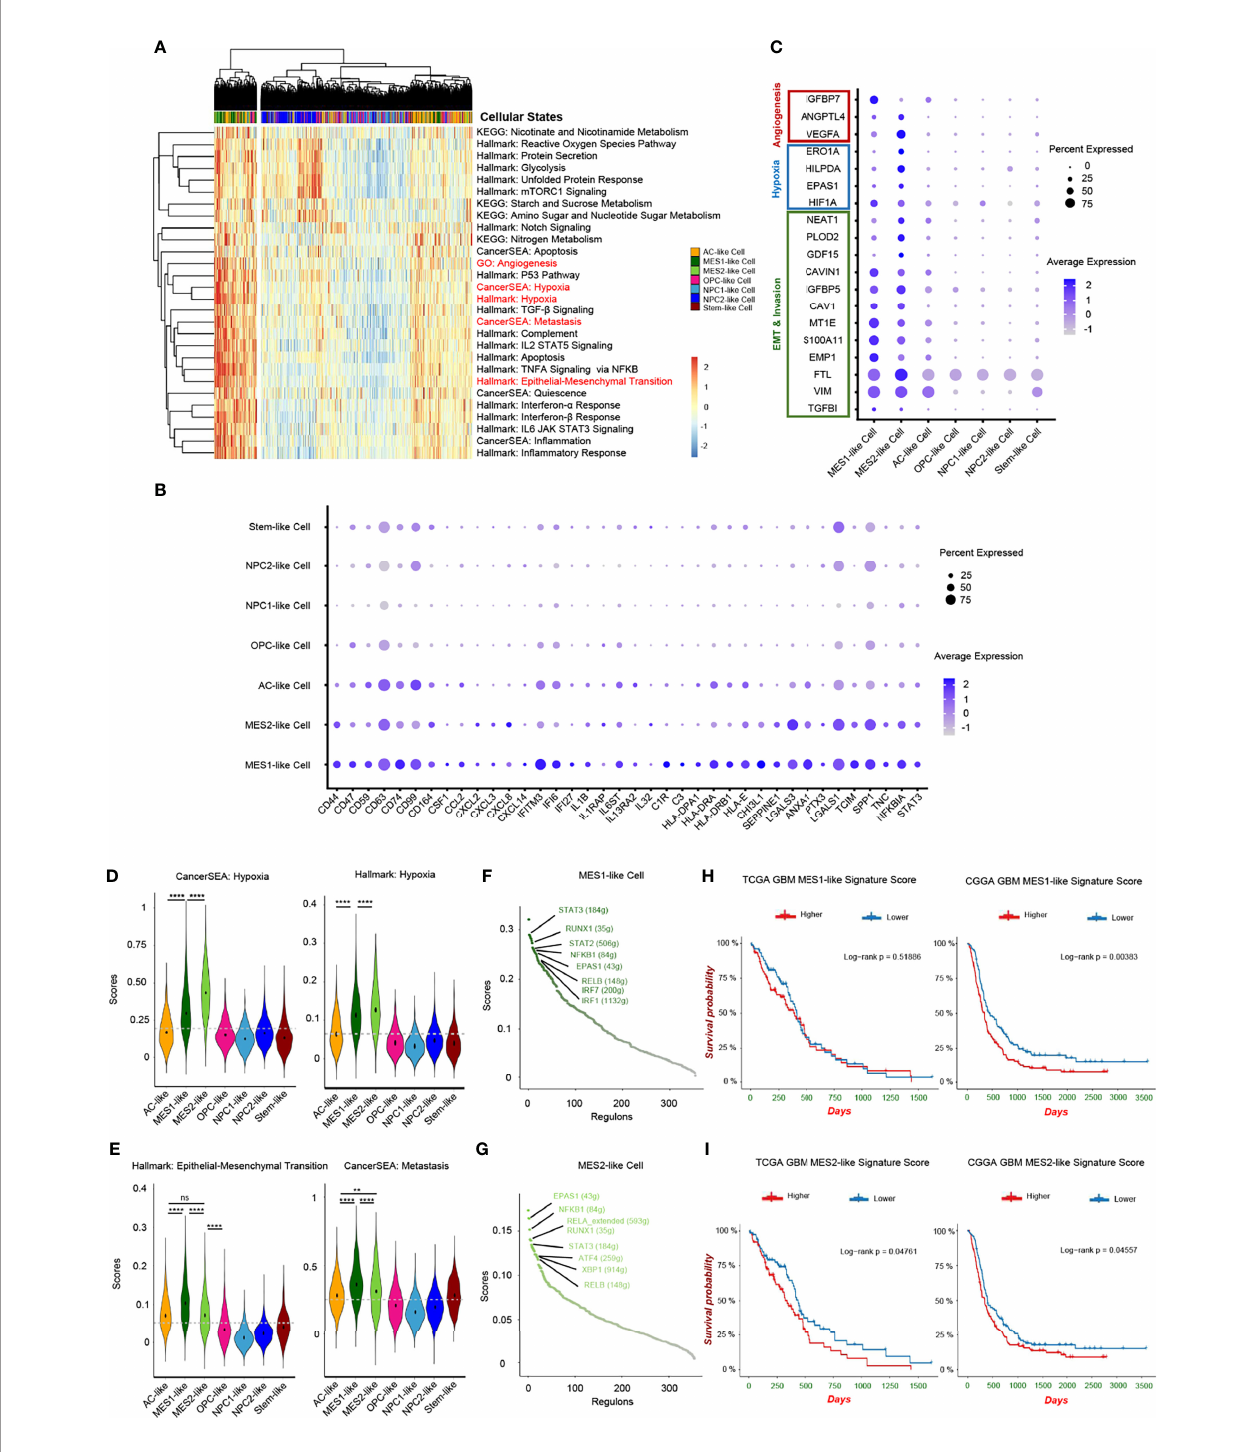
FIGURE 4 | Hypoxia-response tumor cells in GBM. (A) Heatmap of cancer-speci fi c gene sets in the six cellular states and stem-like cells. (B) Upregulated immune gene pattern in MES1-like and MES2-like cells. (C) High expressed genes related to angiogenesis, hypoxia, and invasion in MES1-like and MES2-like cells. Violin plot of the hypoxia (D) , and epithelial – mesenchymal transition and metastasis (E) gene set scores in the six cellular states and stem-like cells. MES1-like and MES2-like cells were the hypoxia-response tumor cells in GBM. The activated regulons in the MES1-like (F) and MES2-like (G) cells ranked by regulon speci fi city score from high to low. Survival analysis of the MES1-like (H) and MES2-like (I) cell signatures in TCGA and CGGA GBM databases, respectively. Gray dash line, average score; ns, no signi fi cance; ** p < 0.01; **** p < 0.0001. See also Supplementary Figure 4 and Supplementary Table 4